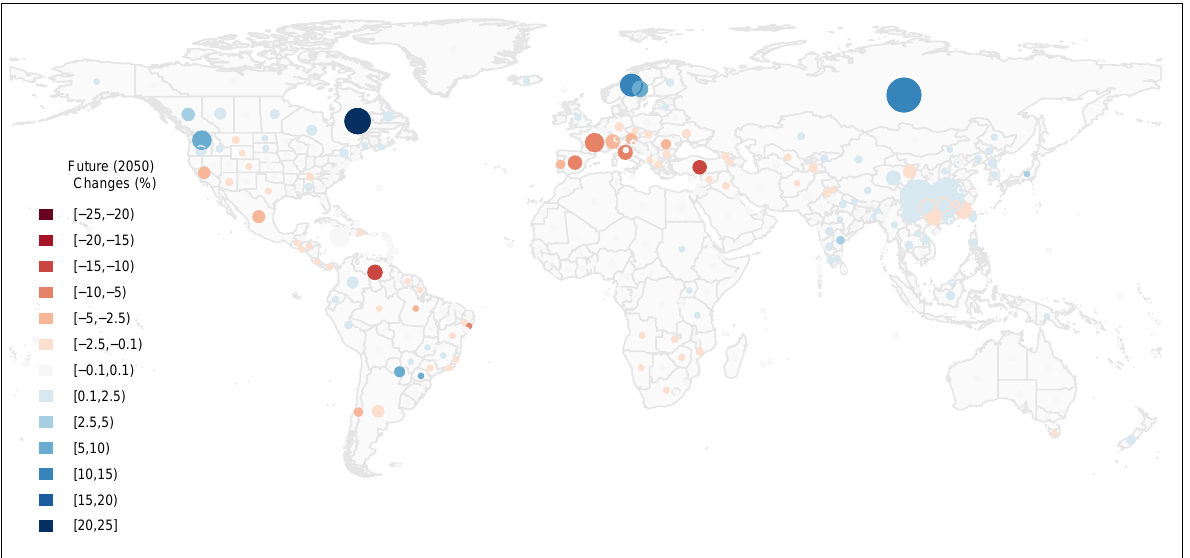
Figure 5. Percentage Changes in Global Hydropower generation resulting from 12 GCMs (AR4 2007) under A1B scenario.